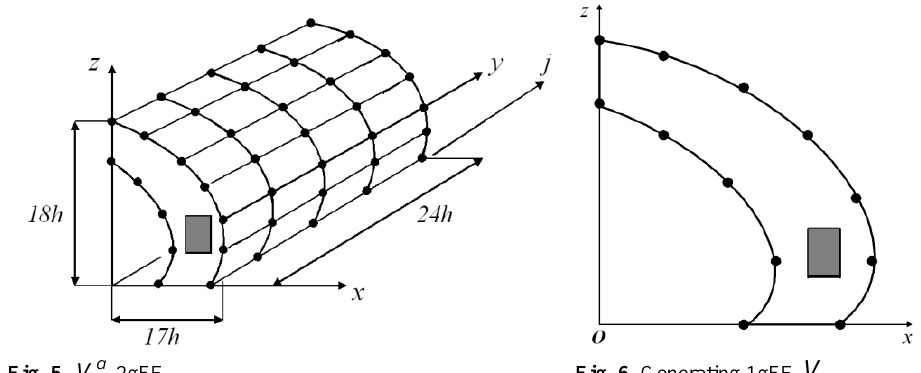
2gFE. Fig. 6. Generating 1gFE a V